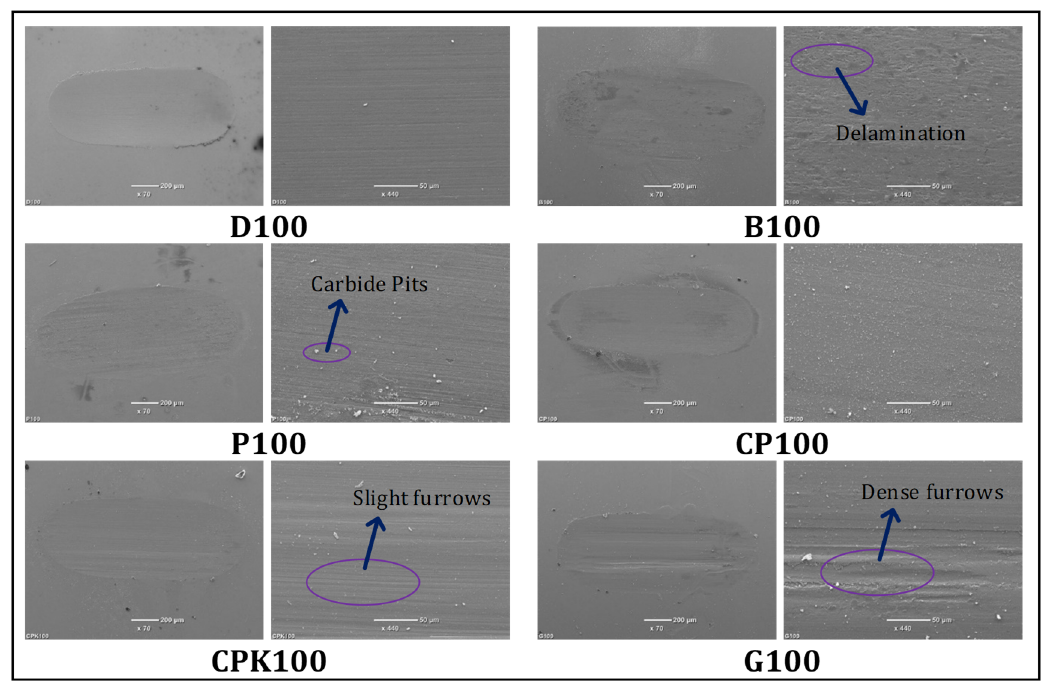
Figure 2. SEM and topography micrographs of a disc tested in different